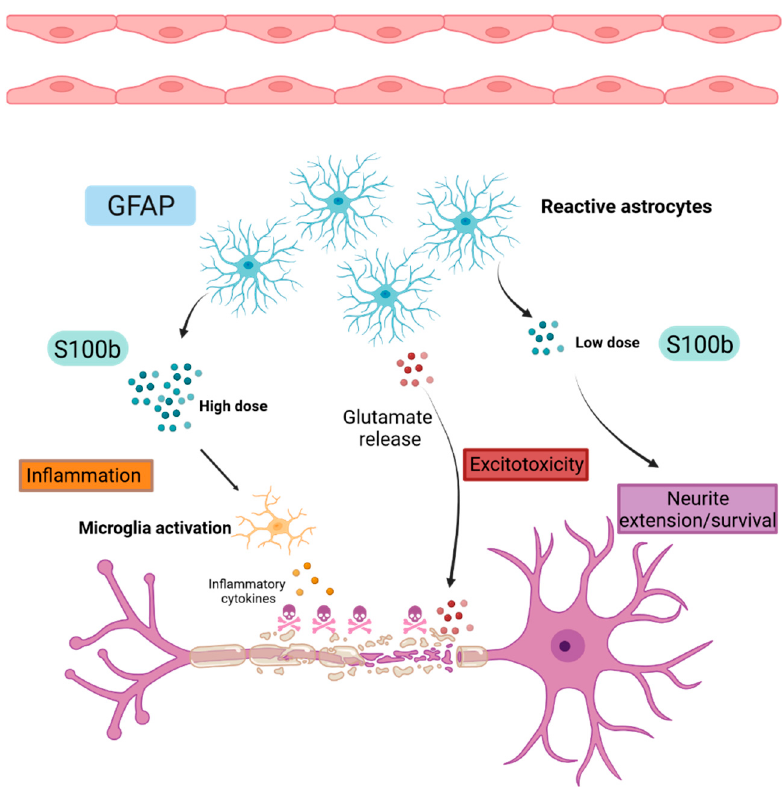
Figure 3. Schematic representation of astrogliosis. GFAP: Glial Fibrillary Acidic Protein, S100b: S100 calcium binding protein B.